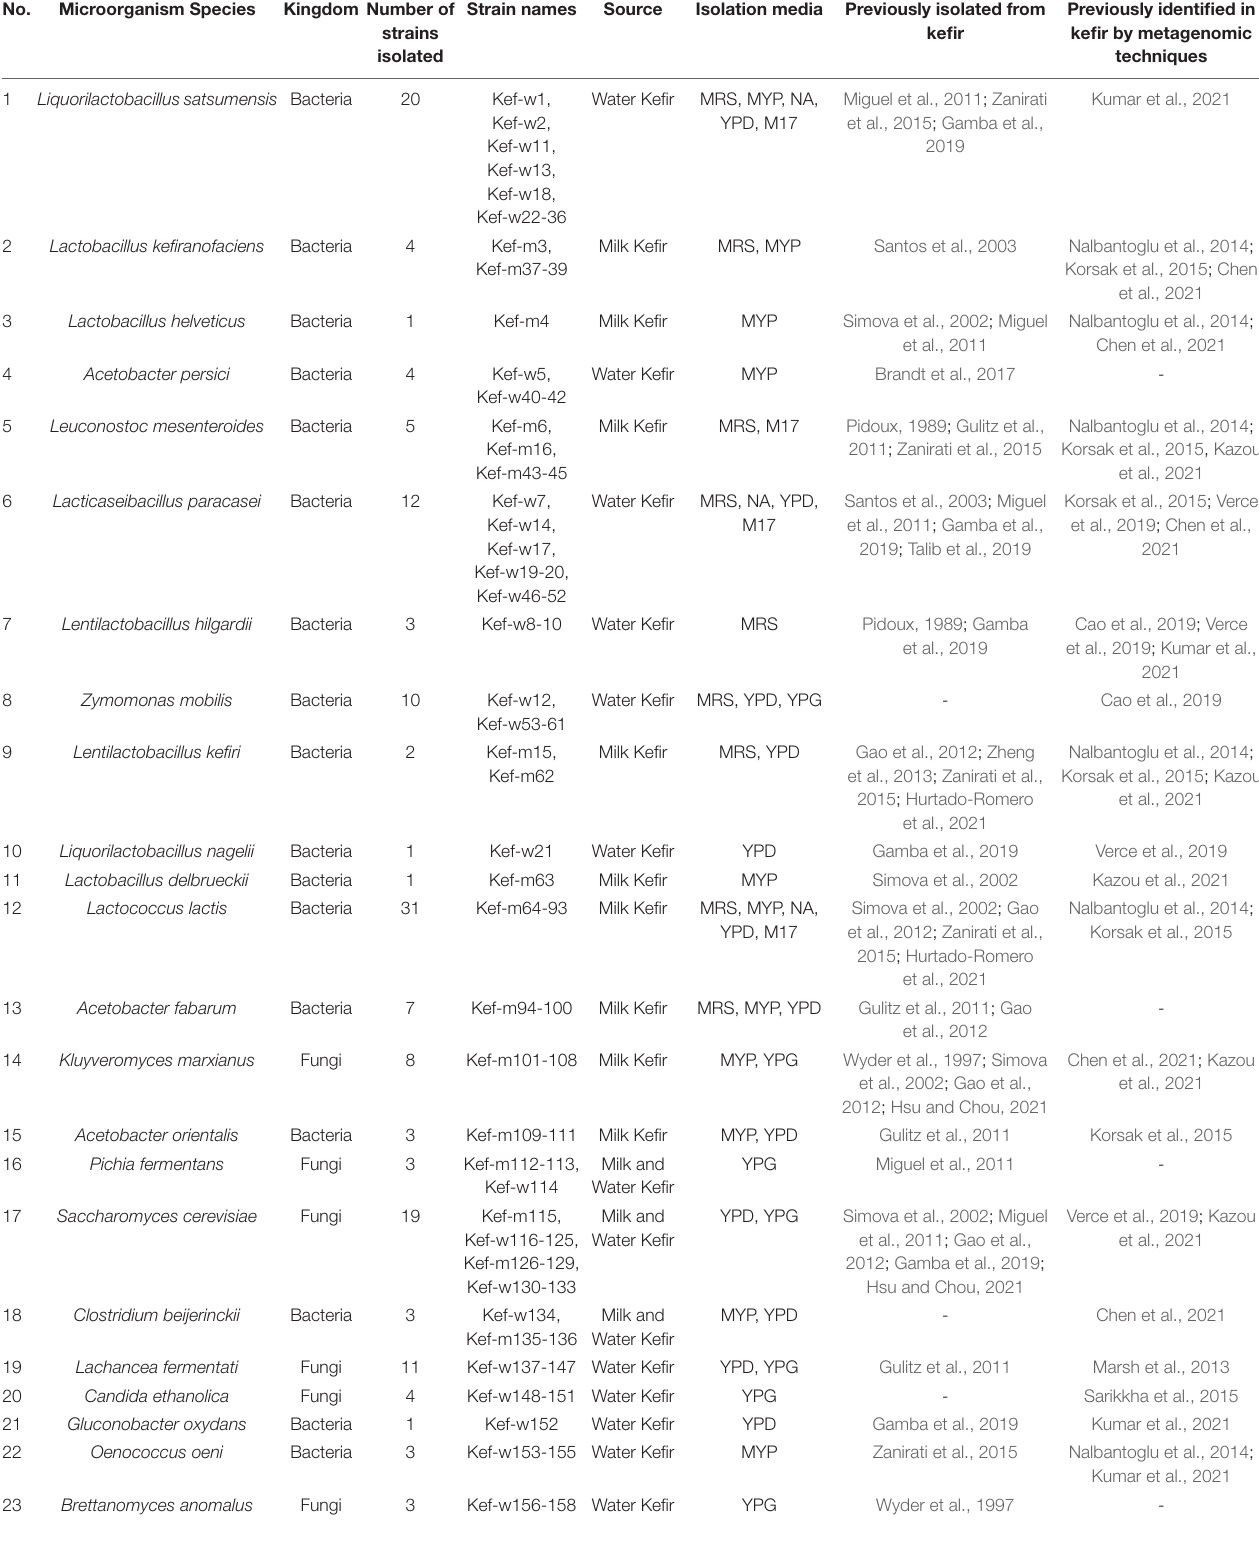
TABLE 3 | List of microbial strains isolated from milk and water kefir.